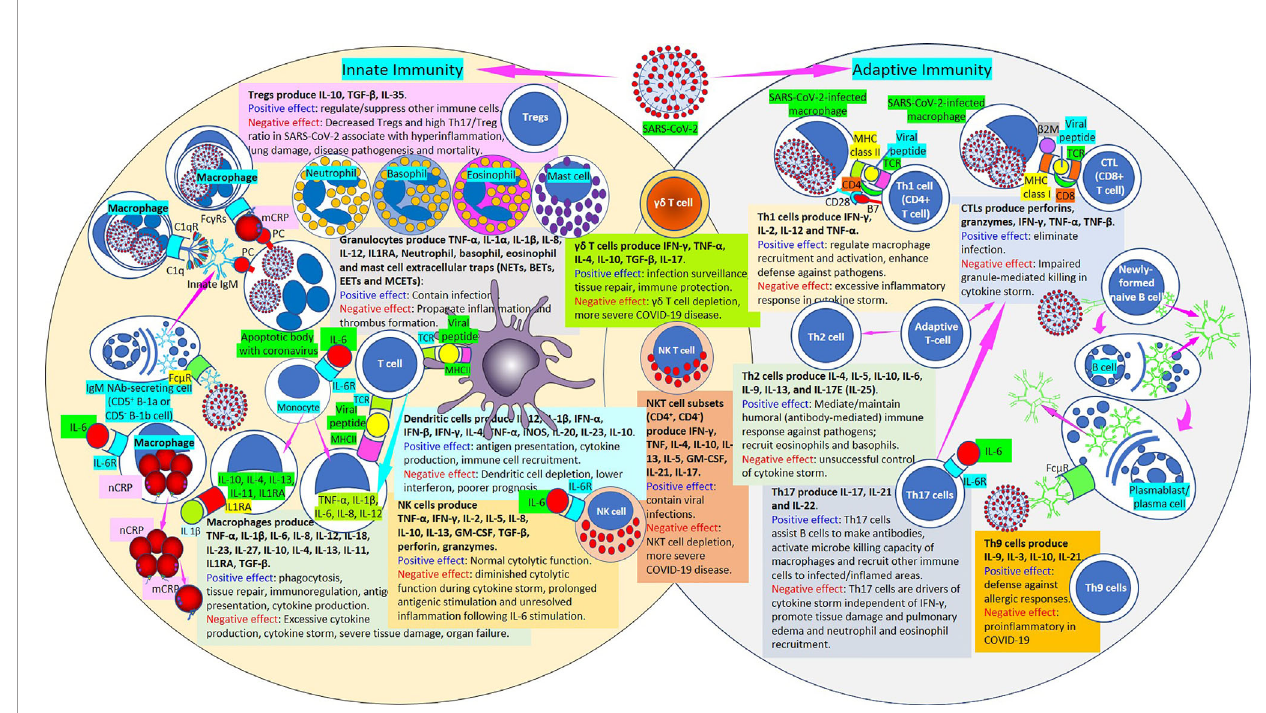
FIGURE 11 | Innate and adaptive immunity in SARS-CoV-2. [Left circle] The innate immune response functions as the fi rst line of defense against infection. It consists of soluble factors, such as native (n) and monomeric (m) C-reactive protein (CRP) produced by liver and macrophages locally; innate IgM produced by B cells; complement proteins (C1q), and diverse cellular components including granulocytes (basophils, eosinophils and neutrophils), mast cells, monocytes, macrophages, dendritic cells, regulatory T cells (Tregs) and natural killer cells. [Middle intersection] Natural killer T cells and gd T cells are cytotoxic lymphocytes that straddle the interface of innate and adaptive immunity. [Right circle] The adaptive immune response is slower to develop, but manifests as increased antigenic speci fi city and memory. It consists of antibodies, B cells that produce adaptive IgM and other antibodies, Th1 CD4 + , CTL CD8+ T lymphocytes, Th2 cells, Th17 cells, Th9 cells, among others. SARS-CoV-2, severe acute respiratory syndrome coronavirus; Tregs, regulatory T cells; IL, interleukin; Th, T helper; TNF, tumor necrosis factor; IL1RA, IL-1 receptor antagonist; NETs, neutrophil extracellular traps; BETs, basophil extracellular traps; EETs, eosinophil extracellular traps; MCETs, mast cell extracellular traps; Fc g Rs, Fc g receptors; C1q, complement 1q; C1qR, C1q receptor; IgM, immunoglobulin M; PC, phosphorylcholine; Fc m R, Fc m receptor; IL-6R, IL-6 receptor; CRP, C-reactive protein; nCRP, native CRP; mCRP monomeric CRP; TGF- b , transforming growth factor- b ; TCR, T cell receptor; MHCII, major histocompatibility antigen class II; IFN, interferon; NK cell, natural killer cell; NKT cell, natural killer T cell; GM-CSF, granulocyte-macrophage colony-stimulating factor; iNOS, inducible nitric oxide synthase; COVID-19, coronavirus disease-2019; b 2M, b 2 microglobulin; MHC class I, major histocompatibility antigen class I; CTL, cytotoxic